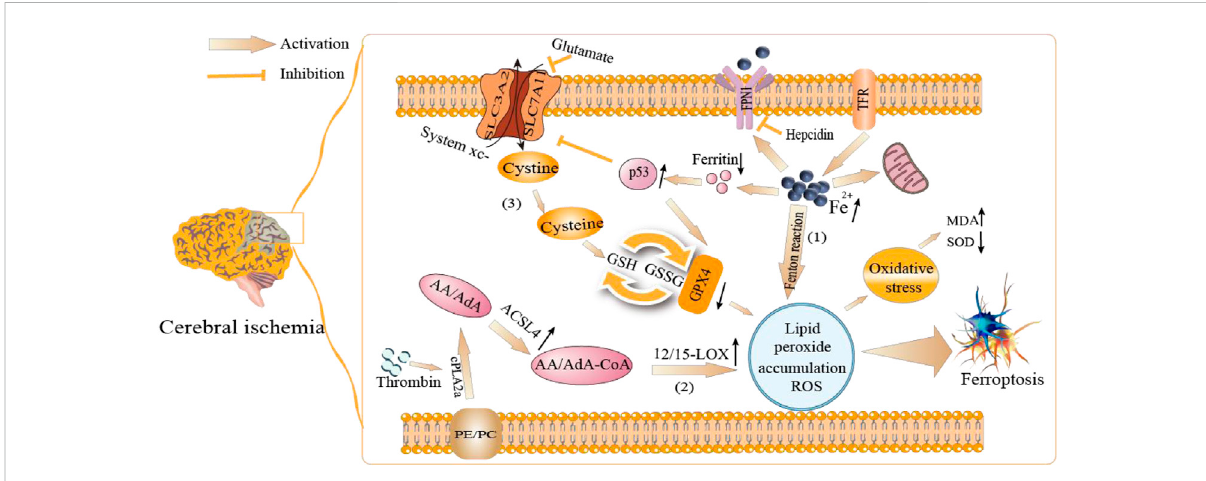
FIGURE 1 The current mechanisms of ferroptosis in cerebral ischemia is mainly attributed to: (1) Iron dyhomeostasis leading to iron overload and ferroptosis. (2) Metabolic imbalances of lipids aggravate accumulation of lipid peroxide and ROS. (3) Amino acid axillary toxicity causes system xc-is impaired, which inhibits cystine-glutamate exchange and decreases the generation of the antioxidant GSH and